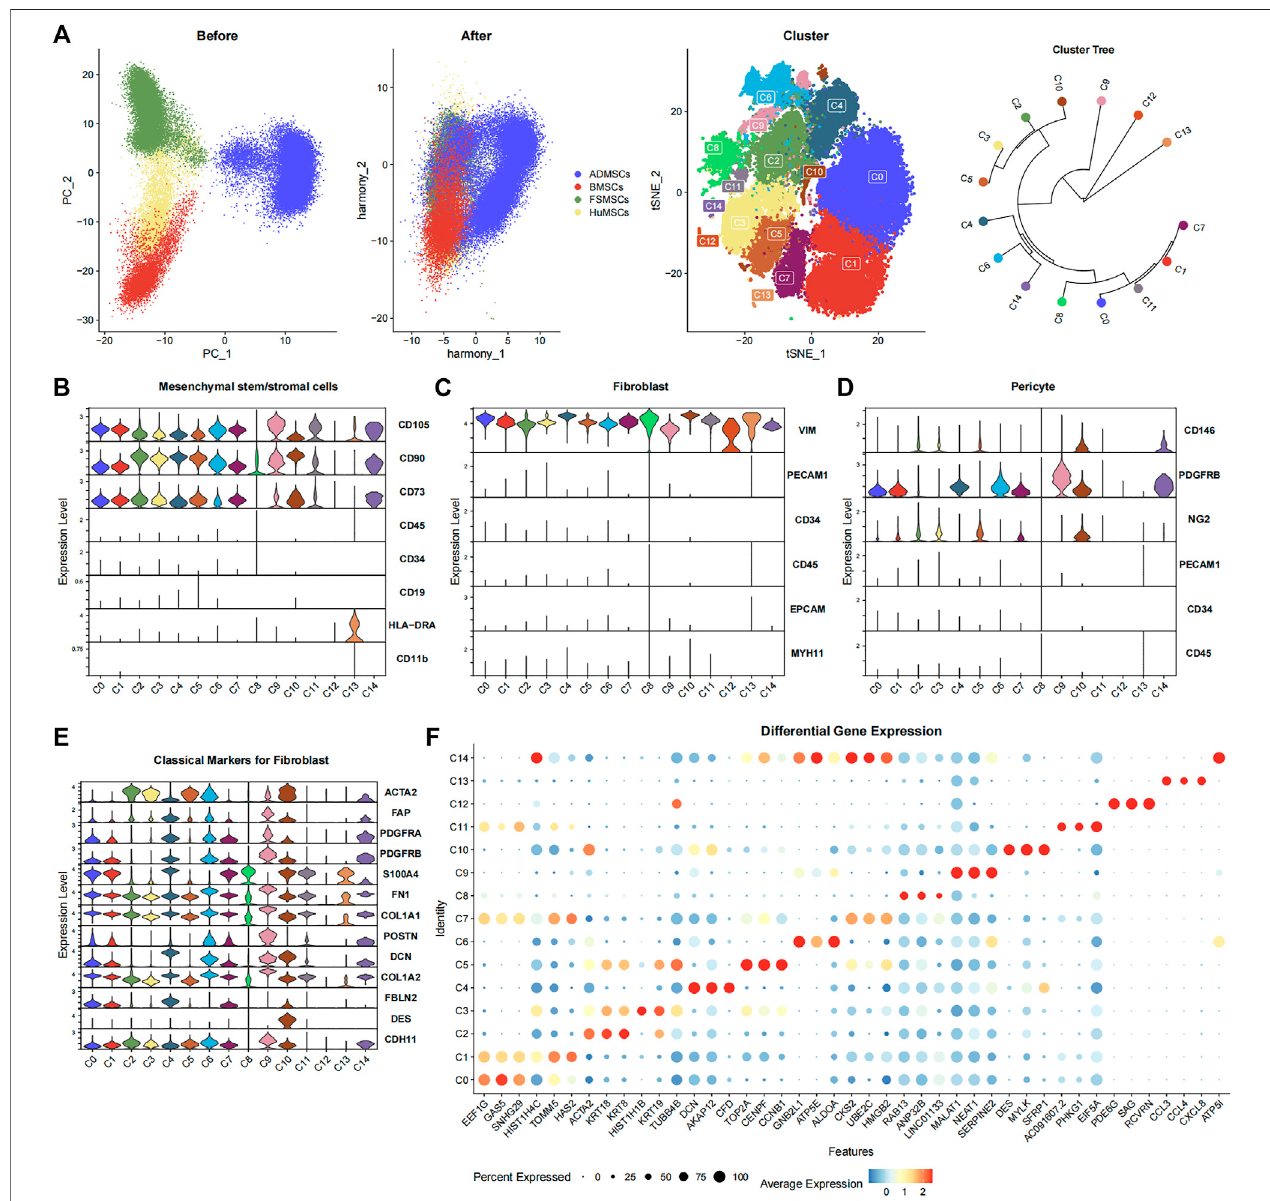
FIGURE1| Characterizationofthe15cellsubsetsderivedfromADMSCs,BMSCs,FSMSCs,andHuMSCsusingvariousbioinformaticsanalysismethods. (A) The PCA plots show the distribution of ADMSCs (blue), BMSCs (red), FSMSCs (green), and HuMSCs (yellow), which are derived from different tissues before and after correcting the batch effects. The TSNE plot shows distribution of the 15 cell subsets (C0 – C14). The clustering tree shows similarity between the 15 cell subsets. (B – D) The violin plot shows the expression status of (B) MSC-related markers, (C) fi broblast-related markers, and (D) pericyte-related markers in the 15 different cell subsets. (E) Theviolinplotshowstheexpressionofclassical fi broblastmarkersinthe15differentcellsubsets. (F) Thebubbleplotshowsthedifferentialexpressionofthe topthreehighlyexpressedgenesineachcellularsubsetamongallthe15cellularsubsets.Thesizeofthebubbleisinverselyproportionaltothe p -value;thatis,thelarger the bubble, the smaller the p -value. The expression level is color coded, with dark red representing high expression and blue representing low expression.